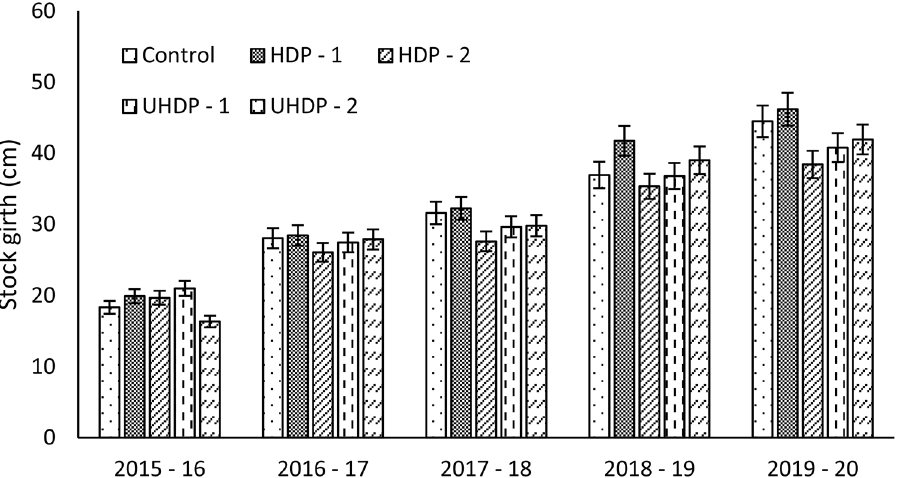
Figure 3. Effect of planting density on stock girth of the plants. Control: Planting at 6 m (row to row) × 6 m (plant to plant) spacing (tree density—277 plants ha −1 ), HDP-1: Planting at 6 m (row to row) × 3 m (plant to plant) spacing (tree density—555 plants ha −1 ), HDP-2: Planting at 4 m (row to row) × 4 m (plant to plant) spacing (tree density—625 plants ha −1 ), UHDP-1: Planting at 4 m (row to row) × 2 m (plant to plant) spacing (tree density—1250 plants ha −1 ), UHDP-2: Planting at 2 m (row to row) × 2 m (plant to plant) spacing (tree density—2500 plants ha −1